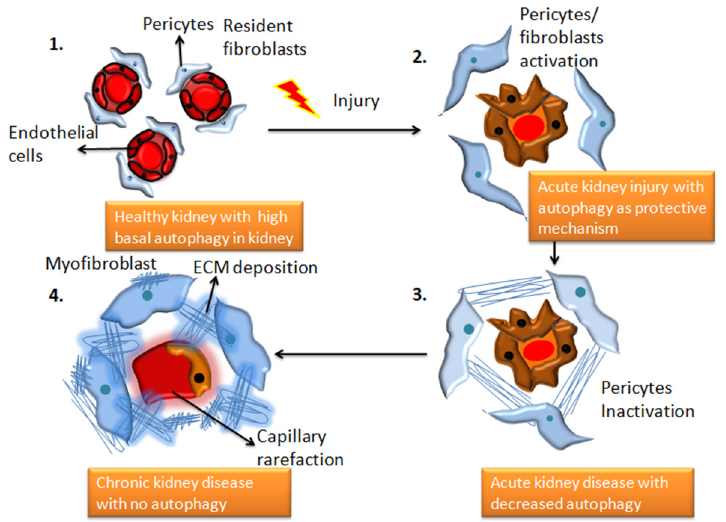
Figure 1. The transition from a healthy kidney to a chronically diseased kidney is associated with changes in autophagy patterns. 1. Demonstrates structurally healthy and physiologically efficient healthy kidney cells with high basal autophagy 2. Depicts the state of renal capillaries following damage caused by an underlying illness, toxins, drugs, or infection. In the extracellular areas, fibroblasts begin to release collagen and fibronectin proteins, and autophagy functions as a protective response, which can be reversible (adaptive repair). 3. AKI worsens to chronic kidney disease, and autophagic activities decline. This stage is characterized by morphological damage to the renal parenchyma and extracellular matrix deposition (maladaptive repair). 4. chronic kidney disease with significant fibrous protein deposition, and no evidence of autophagy.